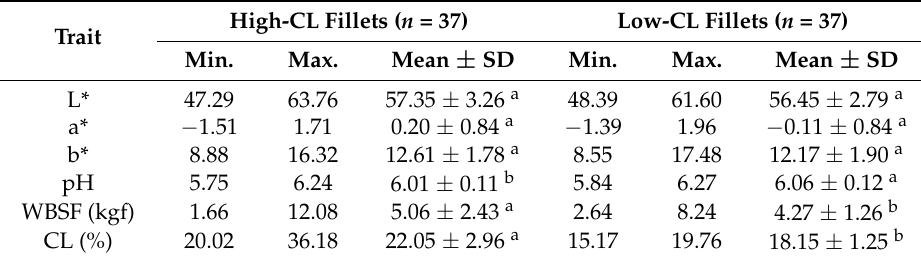
Table 1. Quality attributes of broiler breast fillets with high-CL and low-CL.